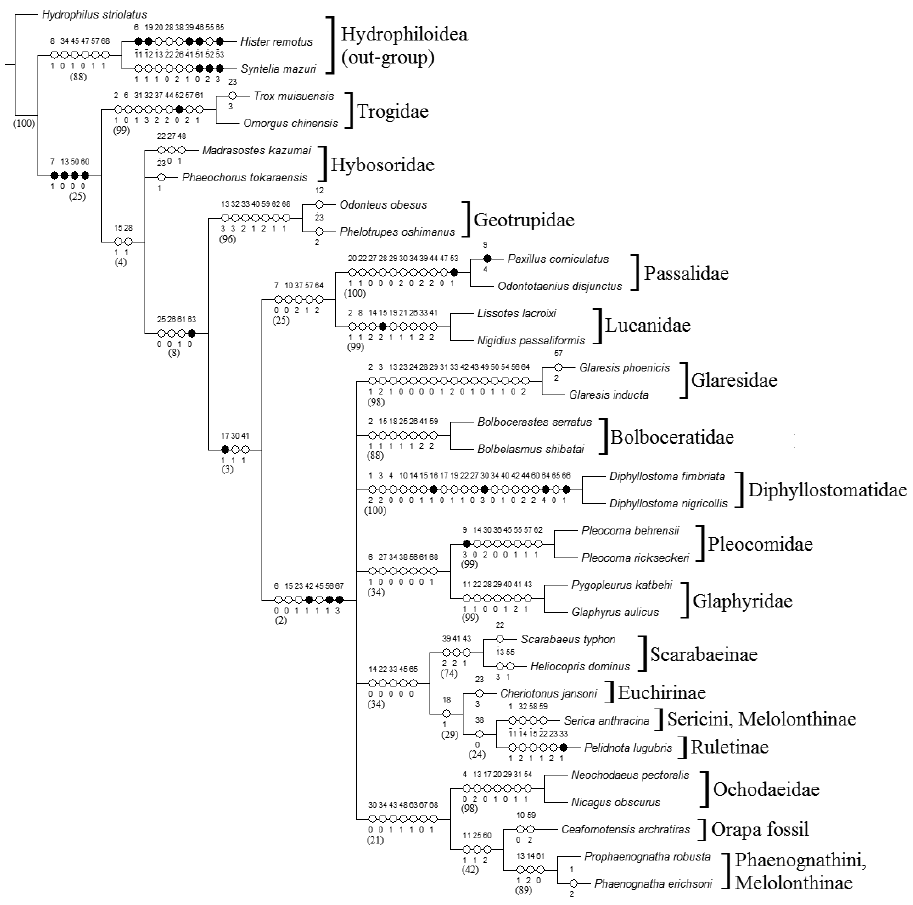
Figure 1. Strict consensus of six most parsimonious trees showing characters (above) and state (below). Bootstrap support values are given in parentheses (tree length=275 steps, ensemble consistency index (CI) = 0.39, ensemble retention index (RI) = 0.64). C. archratiras is referred to as “Orapa fossil”. Character set from Bai et al.